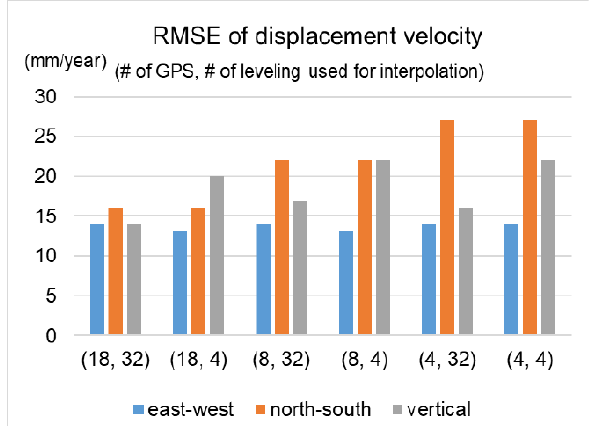
Figure 7. Effect of of the number of GPS and leveling points used for interpolation on land displacement